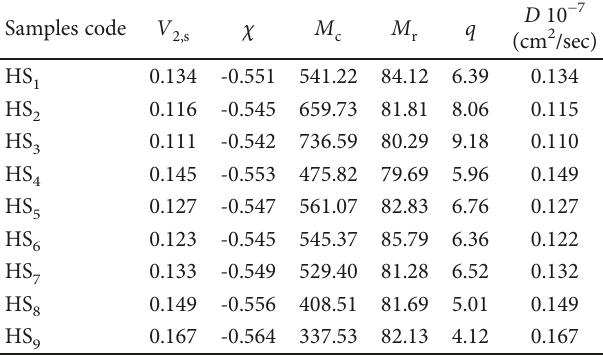
Table 3: Molecular weight between crosslinks ( M density ( q ), and solvent interaction parameter values ( χ ). Samples